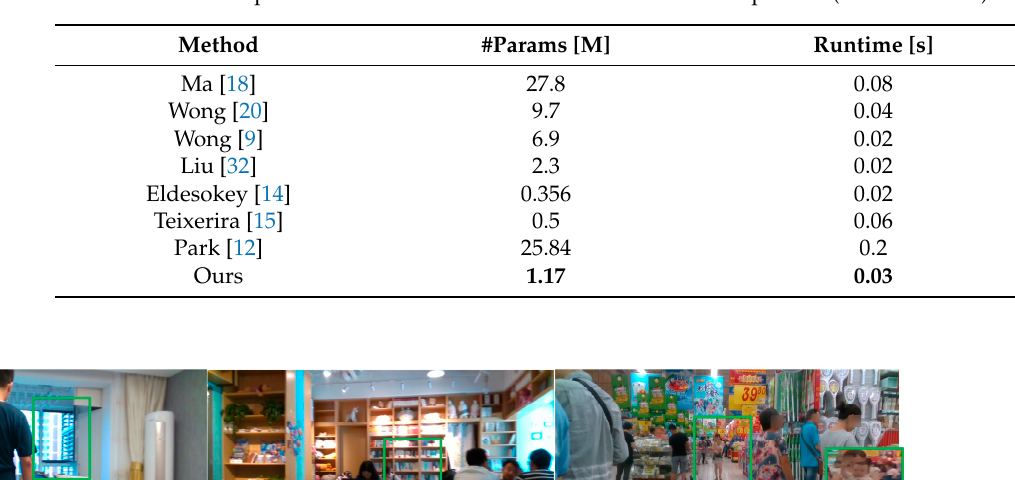
Table 7. Number of parameters and runtime for some methods in comparison (lower is better).